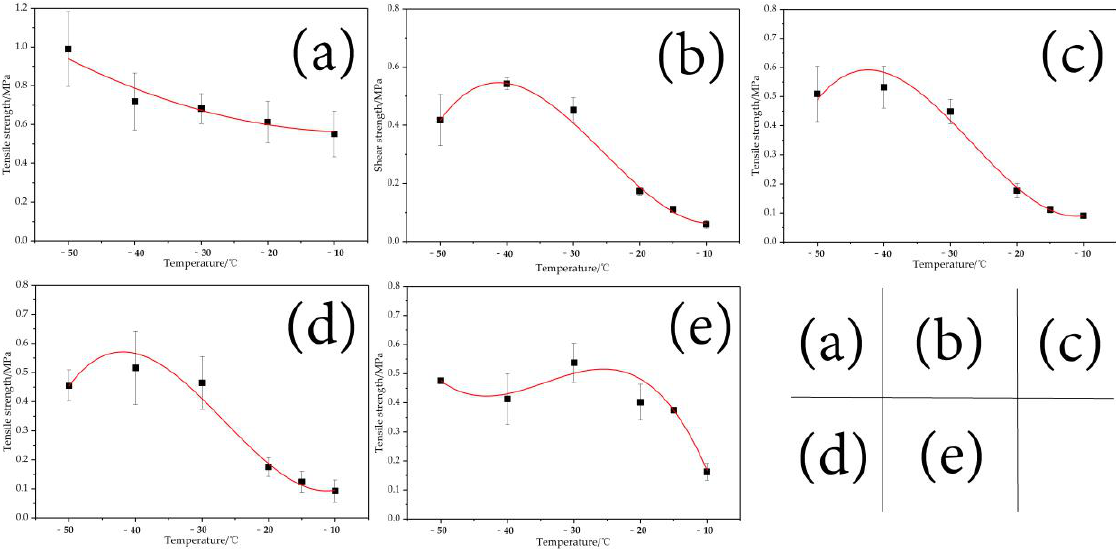
Figure 23. Tensile strength test results. Tensile strengths of ( a ) freshwater ice, ( b ) Dalian seawater ice, ( c ) Qingdao seawater ice, ( d ) Fuzhou seawater ice, and ( e ) Zhuhai seawater ice are shown.